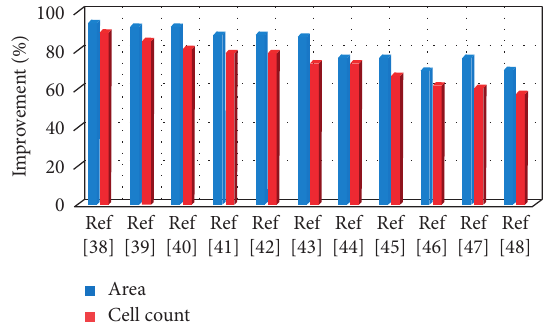
Figure 6: Improvements of proposed adder over others. Table 4: Power analysis results of the proposed 3-input XOR gate and previously reported designs. Three-input XOR gate